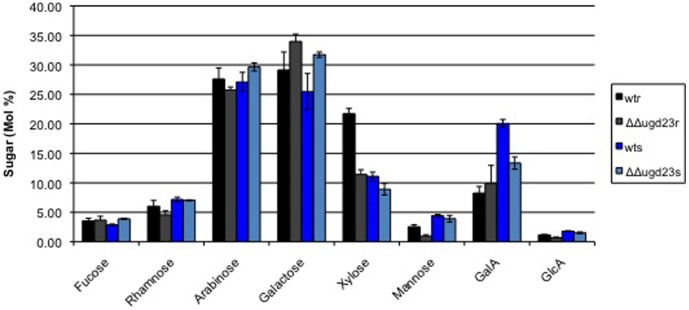
Cell wall sugars in syncytia and roots of wild type plants and ΔΔugd23 mutant at 14 dpi.The sugar composition of cell walls was analysed via HPLC anion-exchange column. Values are mol% ±SE. Each measurement was carried out in at least three independent replicates. wtr: wild type root, ugd23r: ugd23 root, wts: wild type syncytium, ugd23s: ugd23 syncytium.